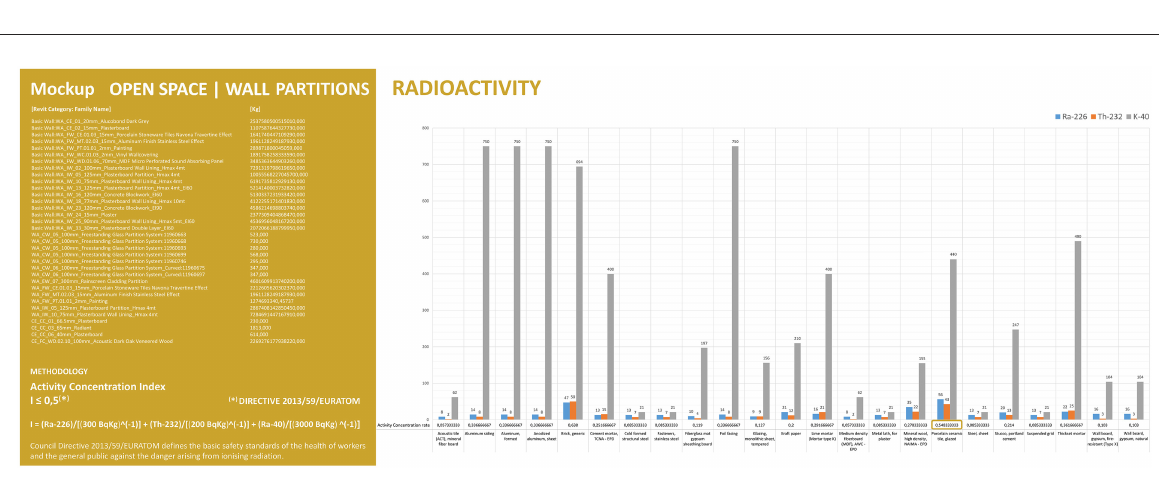
FIGURE6 Radioactivity analysis of the interior wall partitions and finishes, categorized by activity concentrations of uranium, thorium, and potassium (Bq kg − 1 ), and calculation of the activity concentration index in each material.